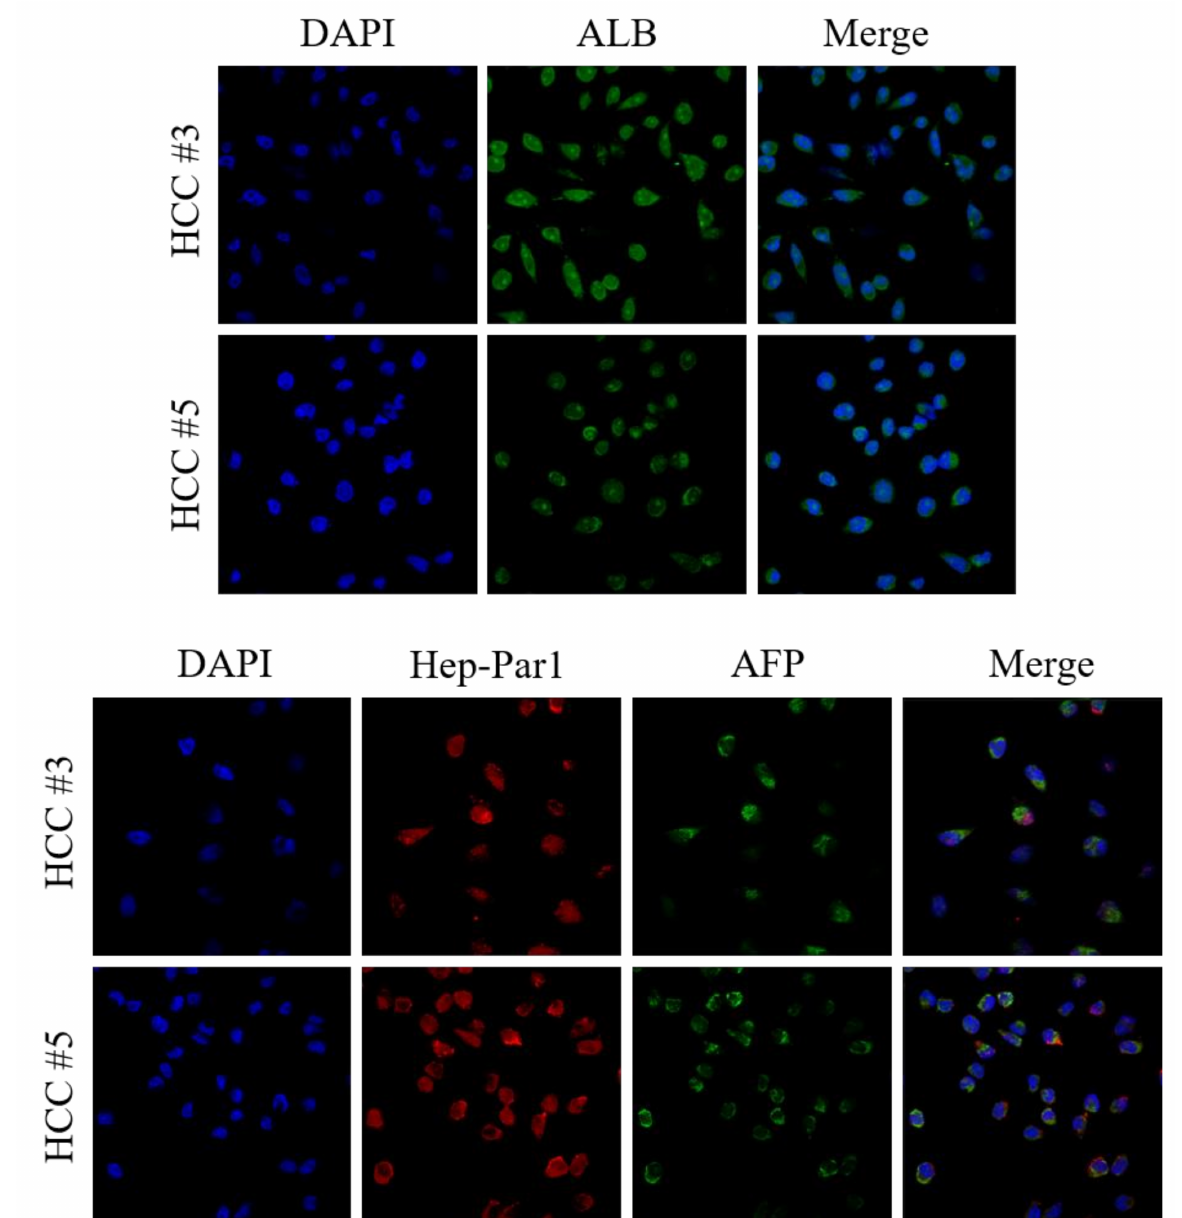
Figure 4. AFP, albumin, and Hep-Par1 immunocytochemical staining of primary HCC cells. AFP, albumin, and Hep Par-1 immunostaining of HCC cell lines were done to examine the cellular origin of primary HCC cells. Representative images were taken under confocal microscopy with a 200 ×